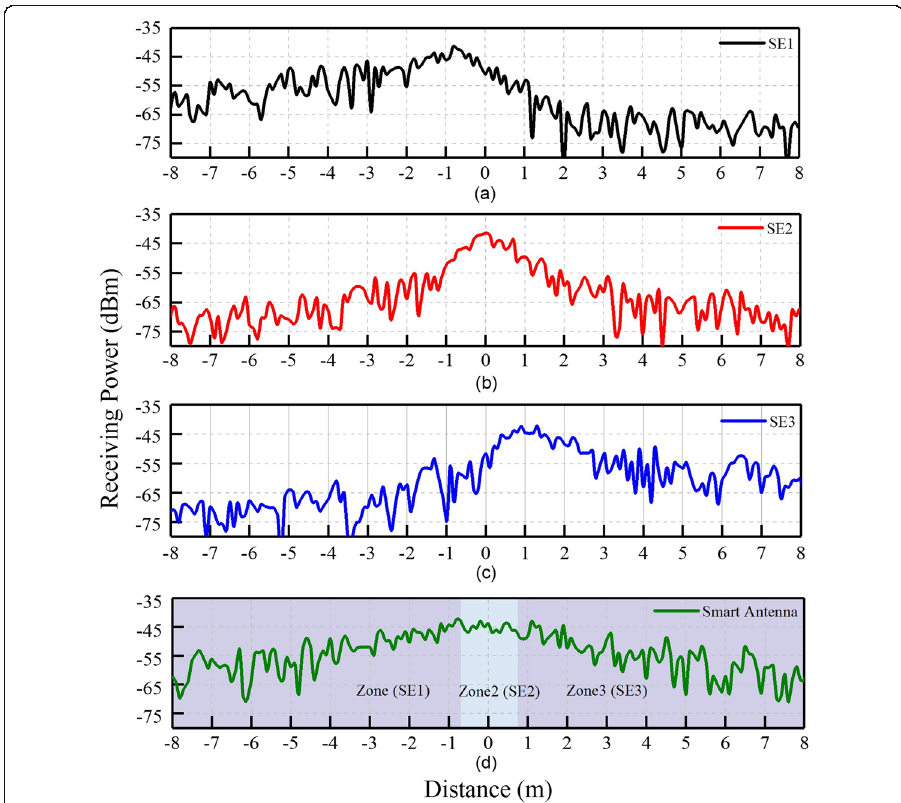
Fig. 14 Distributions of the received power for the transmitting antenna operating in different modes, ( a ), ( b ) and ( c ) are the curves measured along the whole path when only one subelement is excited at a time (without switching), ( d ) is the curve measured when the antenna is operated in the mode of automatic switching in terms of trigger